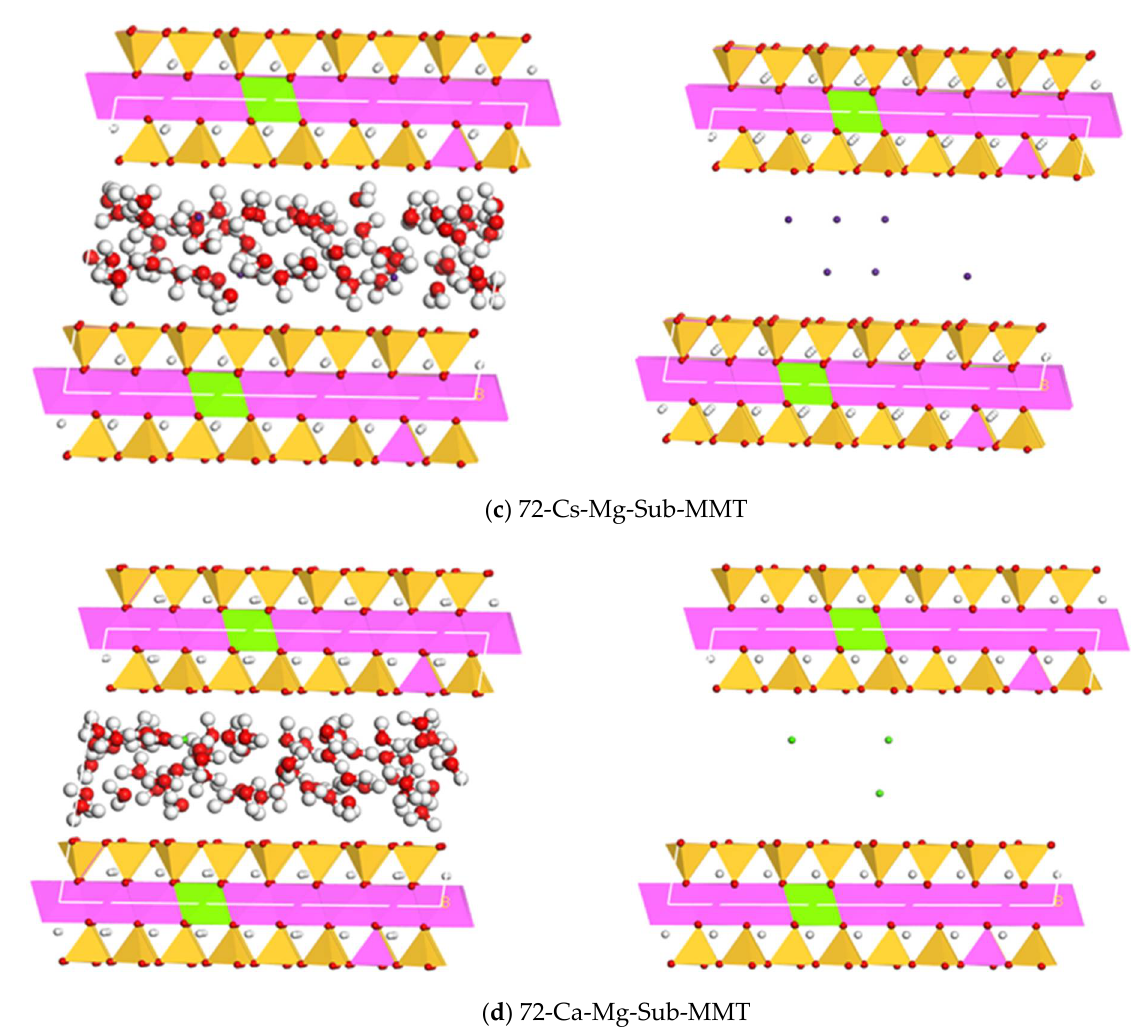
Figure 1. Initial structure of Mg-Sub-MMT with inhibitory cations as counterions. The water molecules in the interlayer are not shown in the right images of different models. The color coding for the atoms is H, white; O, red; Mg, green; Al, pink; Si, gold; K, violet; N, blue; Cs, deep purple; Ca, yellow-green.